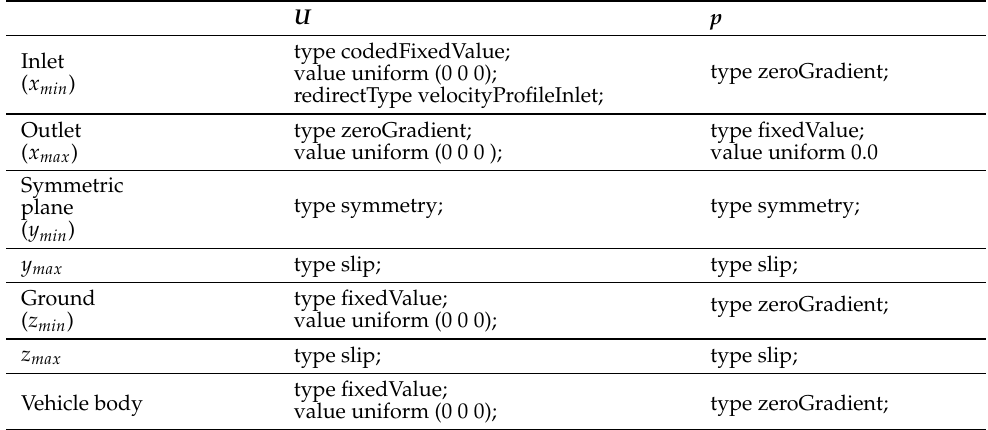
Figure 6. Comparison of the inlet velocity profile of the experimental data with fitted curve using the Blasius boundary layer profile. Table 1. Summary of the boundary conditions of the computational fluid dynamics (CFD) simulation. ( U , p ).